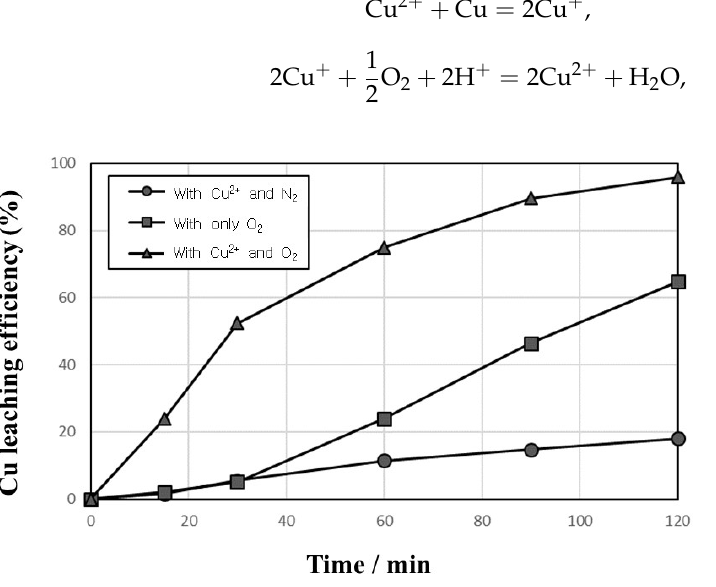
Figure 2. Leaching behaviors of Cu in 1 mol/L sulfuric acid solution with or without 10,000 mg/L Cu 2+ at 90 °C and 600 rpm with 1% pulp density and 1000 cc/min N 2 or O 2 introduction. Equations (2) and (3) could be rearranged into Equation